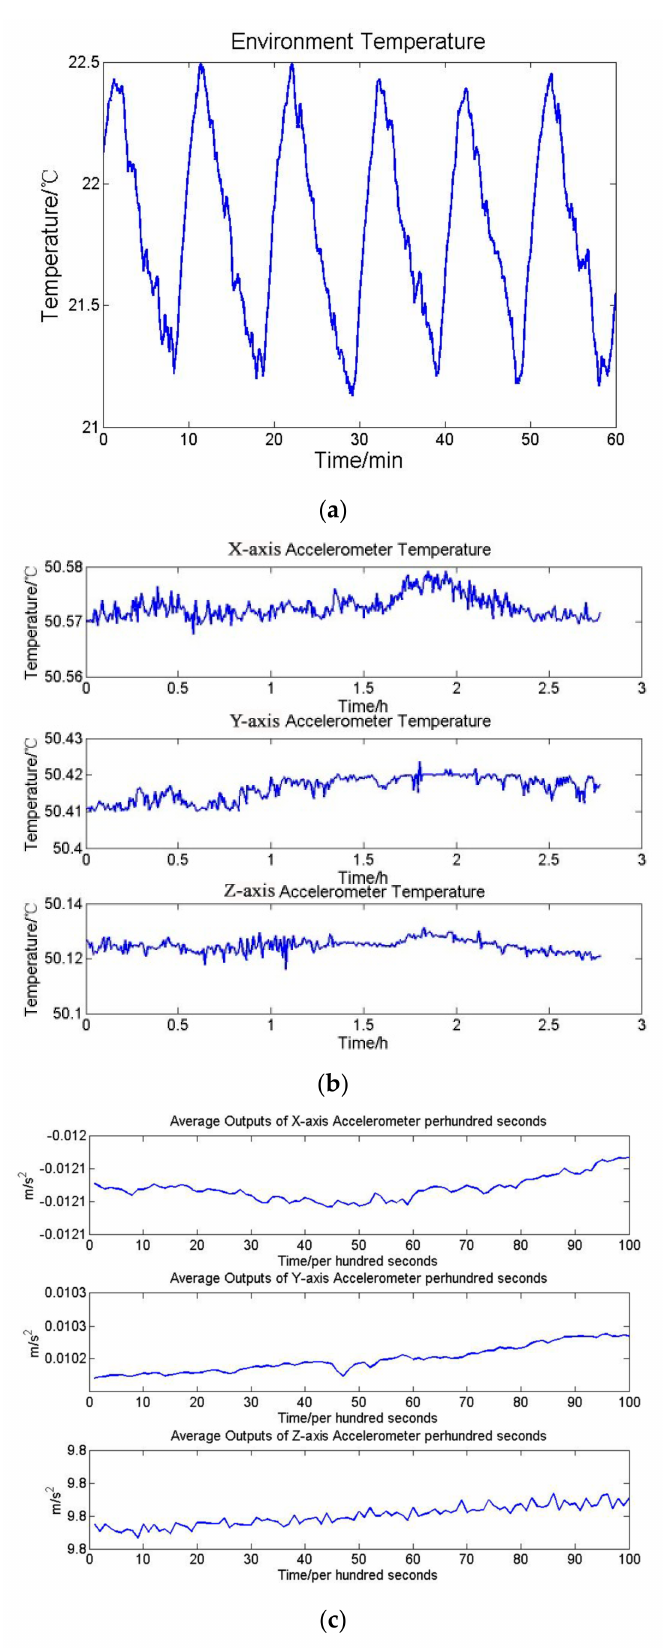
Figure 6. ( a ) Environment temperature variation ( b ) accelerometers temperature variation and ( c ) the average outputs of accelerometers per hundred